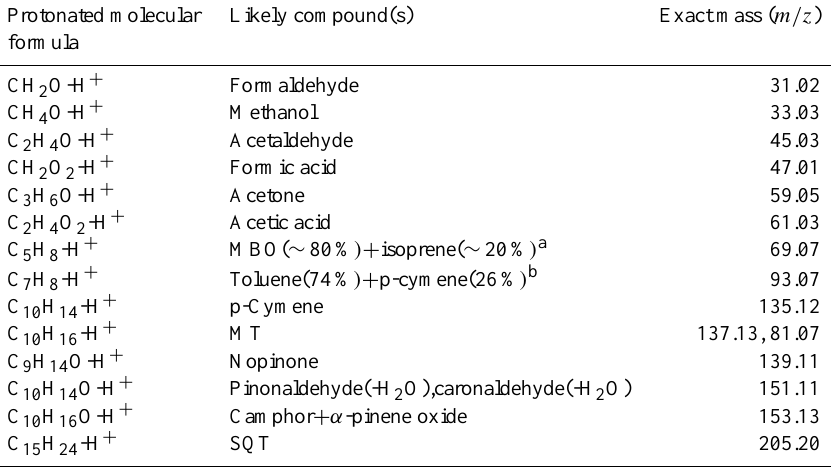
Table 2. List of prominent compounds detected by PTR-TOF-MS in the OFR. Likely compound identifications are taken from previous measurements at the same research site, described in Kim et al. (2010) and Kaser et al.